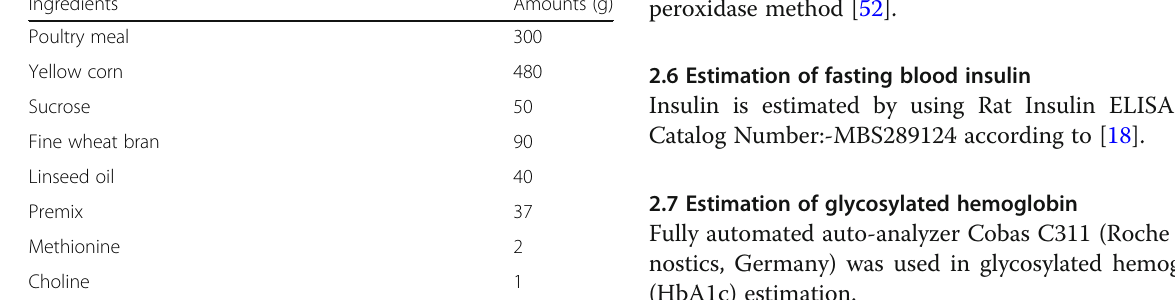
Table 1 Composition of standard balanced ration (g / Kg diet) Ingredients Amounts